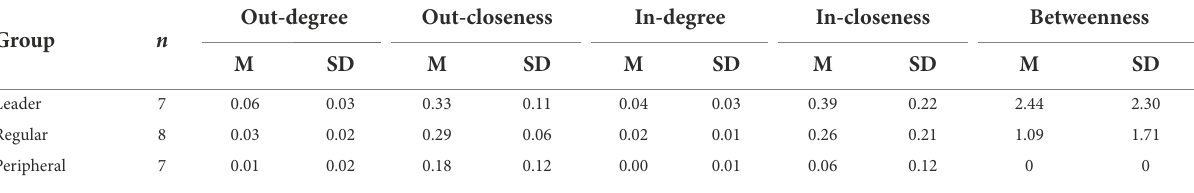
TABLE 5 Means and standard deviations for centrality scores by participation group.